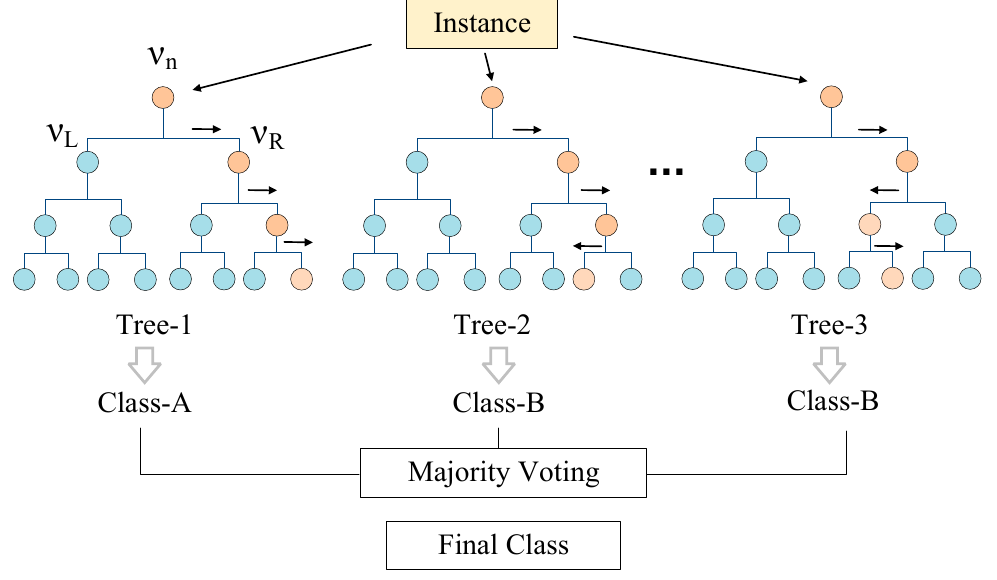
Figure 3. Schematic representation a RF classifier with N trees.